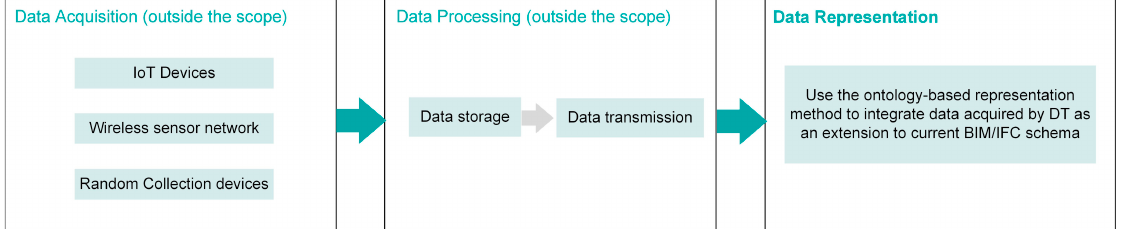
Figure 17. Integration of BIM/IFC and DT